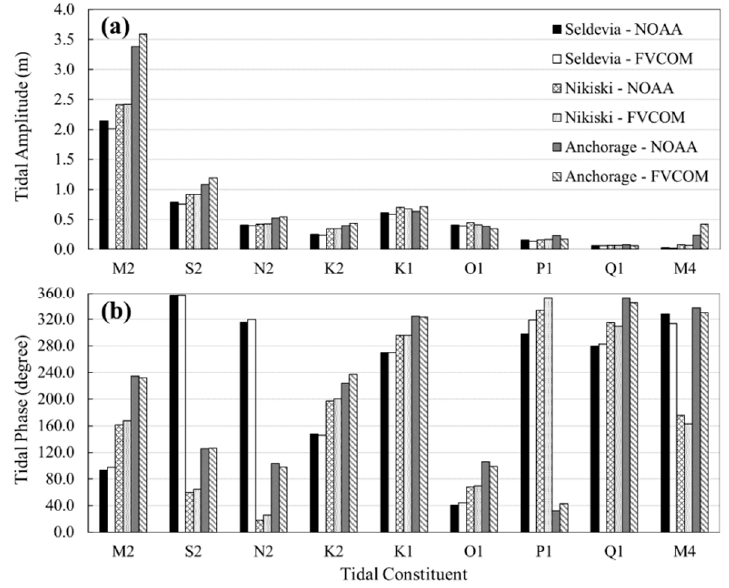
Figure 3. Model-data comparisons of major tidal constituents at three tidal gages inside Cook Inlet ( a ) tidal amplitude and ( b ) tidal phase. ( a ) tidal amplitude and ( b ) tidal